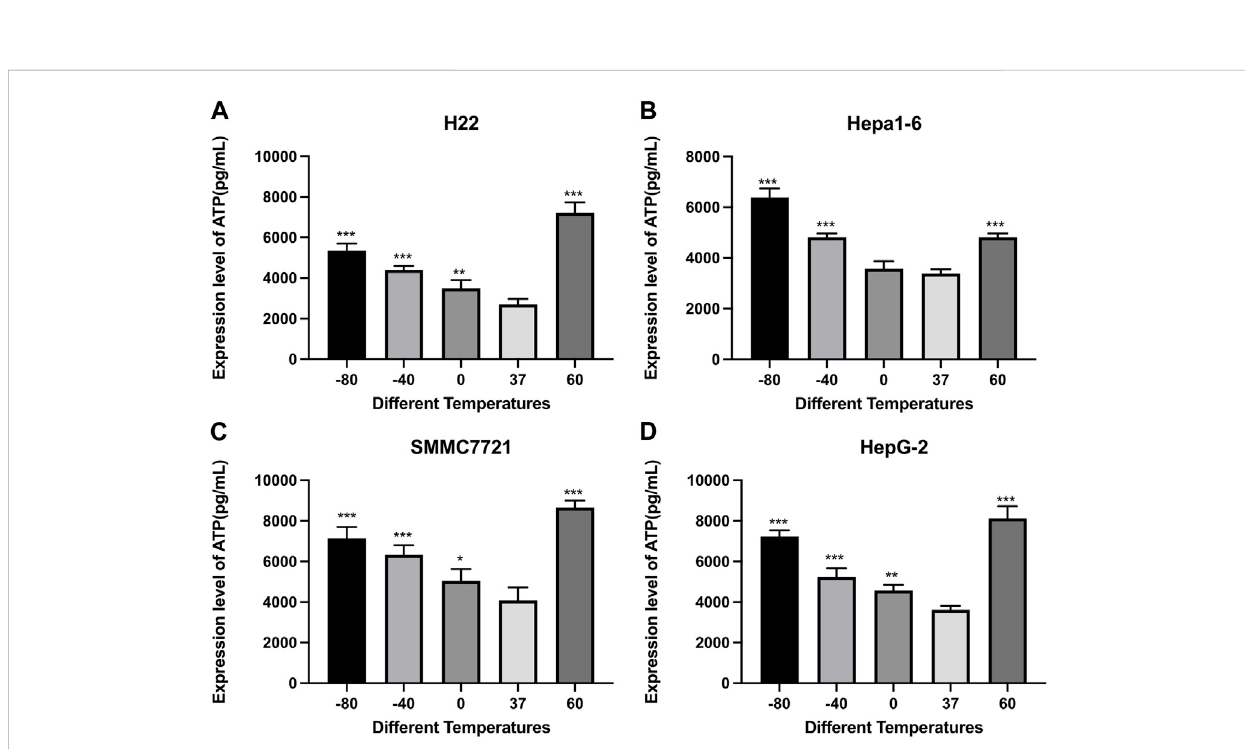
FIGURE 4 Elisa results of ATP level in cell supernatant of (A) H22 cells, (B) Hepa1-6cells, (C) SMMC7721 cells, and (D) HepG2 cells following different thermal ablations (* indicates p < 0.05, ** indicates p < 0.01 and *** indicates p < 0.001).